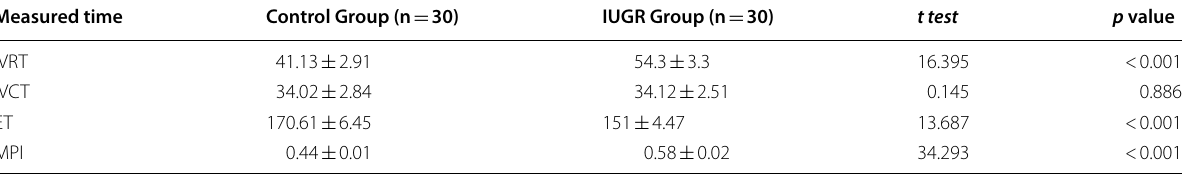
t Independent Sample t =